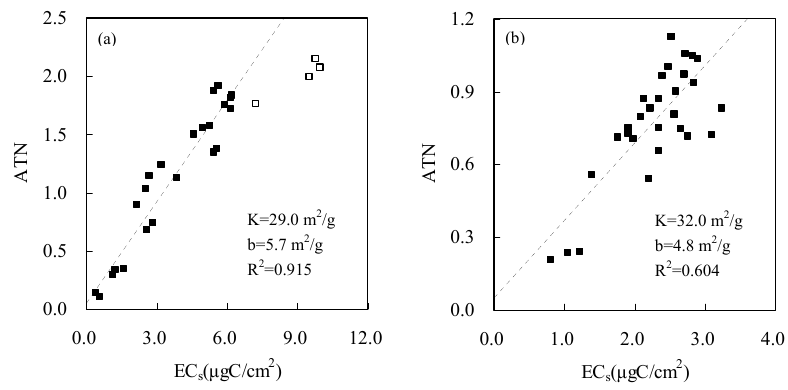
Figure 1. Dependence of light attenuation measured at 632nm (ATN) on the EC loading (EC s ) during winter (a) and summer (b) respectively. Linear regression results are shown with K as the slope and b as the intercept. Data points with EC s exceeding 7µgCcm − 2 , as shown by the open squares, indicated presence of the shadowing effect and were not included when calculating the MAE values.